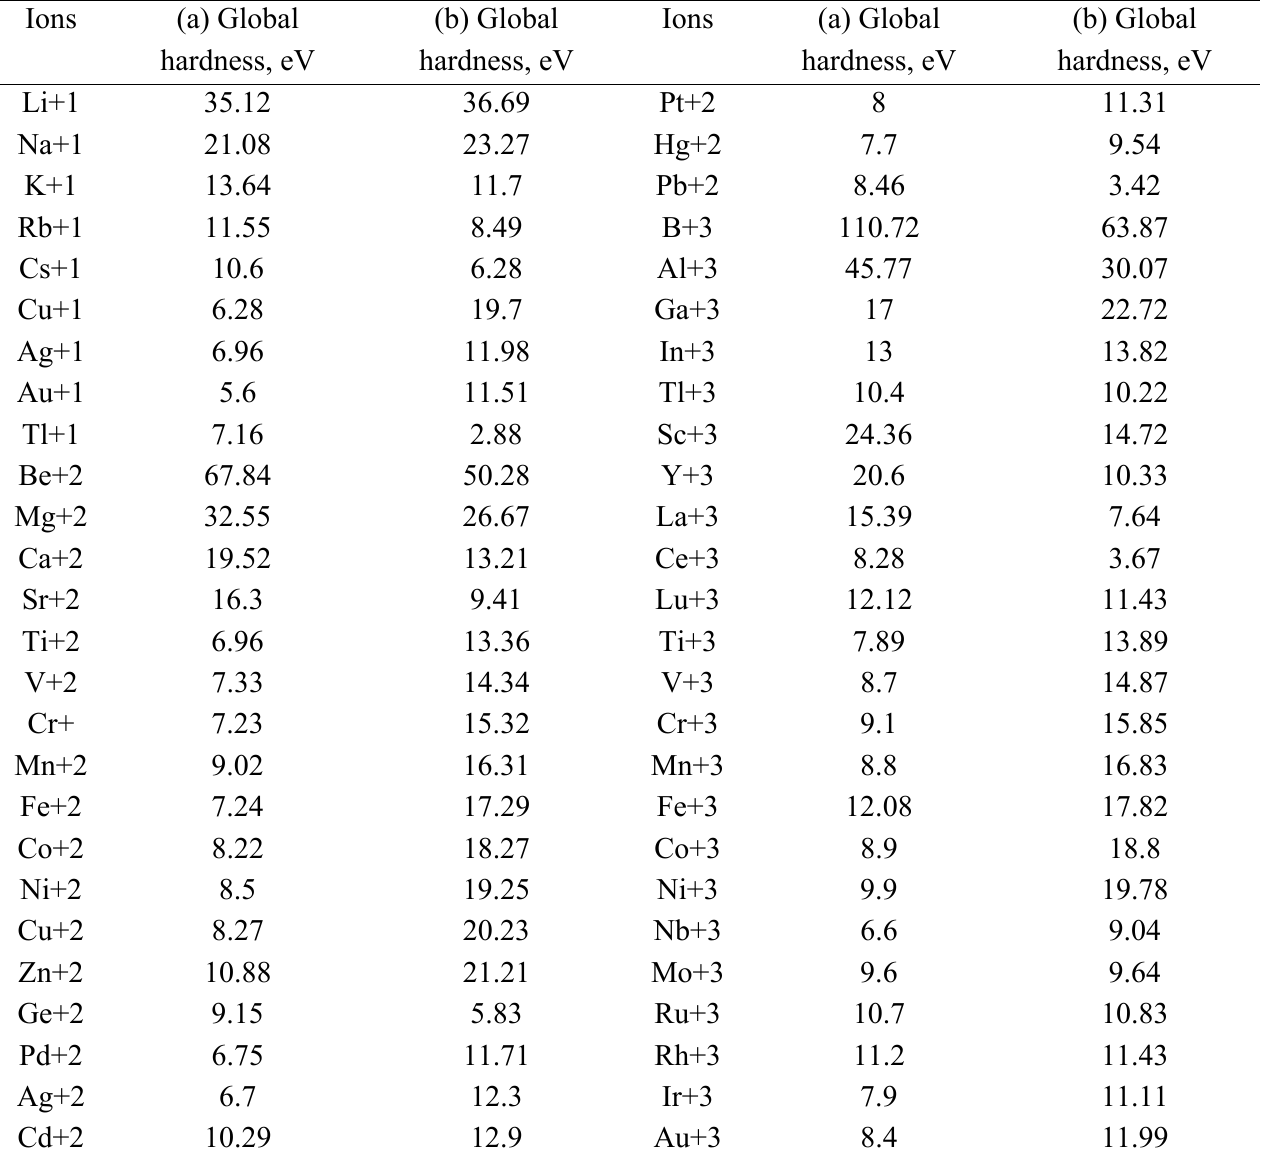
Table 5. Comparative study of (a) experimental (Pearson's) and (b) theoretical global hardness values of